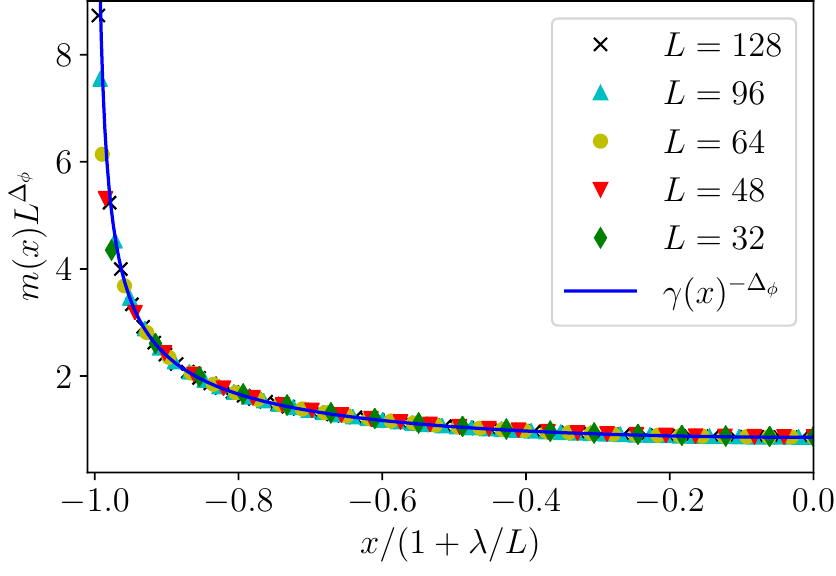
Figure 2 . Magnetization profiles for different sizes, rescaled by L ∆ φ and with the extrapolation length to show the collapse. The transverse direction of the slab is x ∈ [ − 1 , 1] ; the values of the magnetization at x and − x have been averaged, so we plot only the left half of the